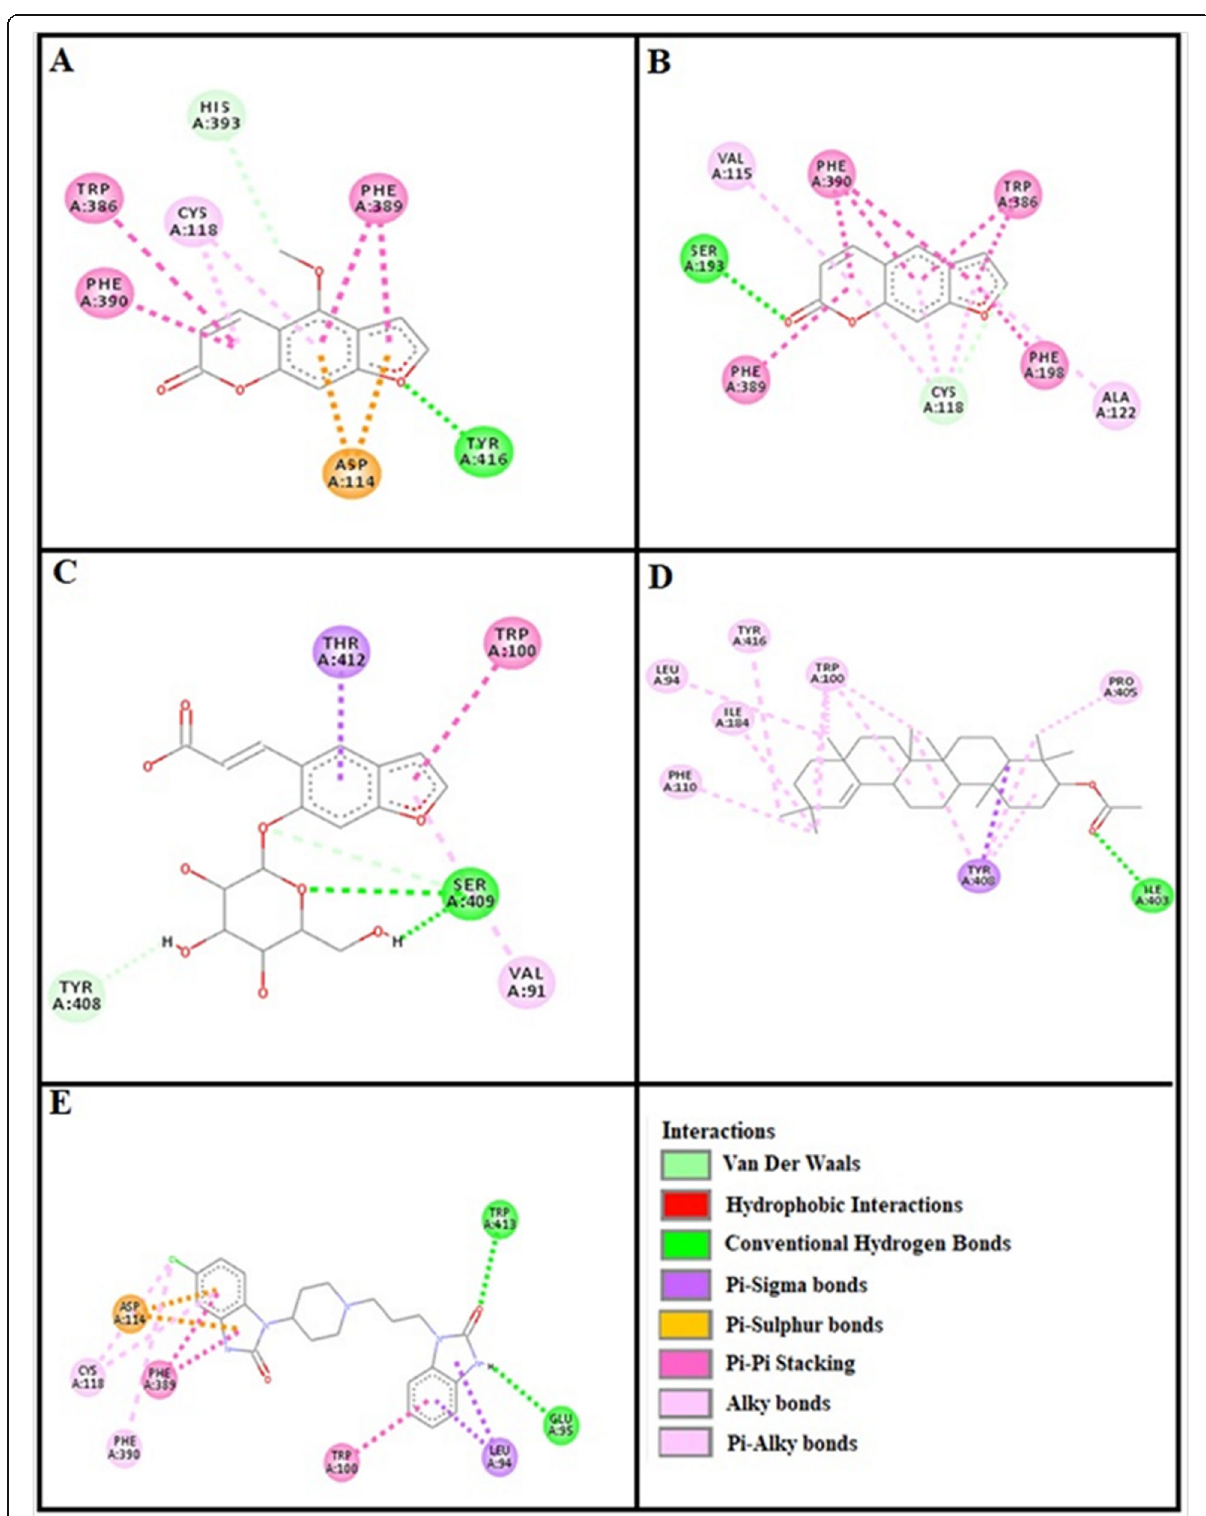
Fig. 10 a , b , c , d and ( e ) represents interactions bergapten, psoralene, psoralenoside, germanicol acetate and calmozolium against target: calmodulin receptor respectively, evaluated through Biovia Discovery Studio